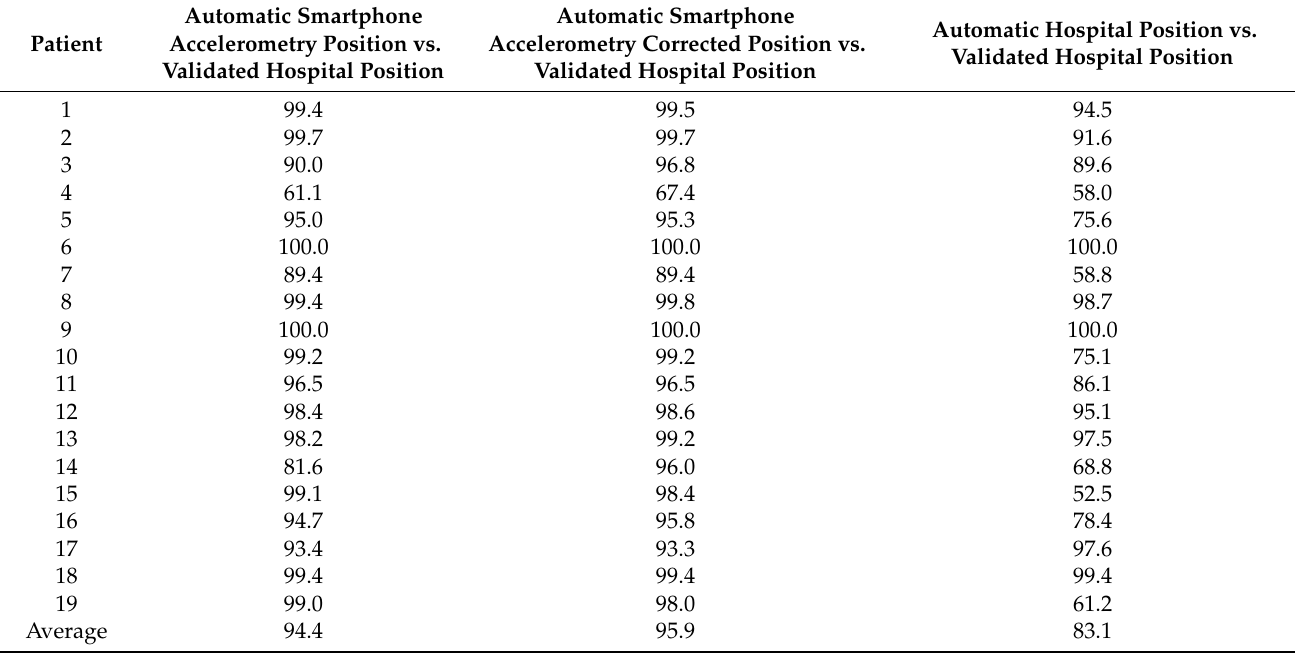
Table 2. Percentage of position agreement between PSG and